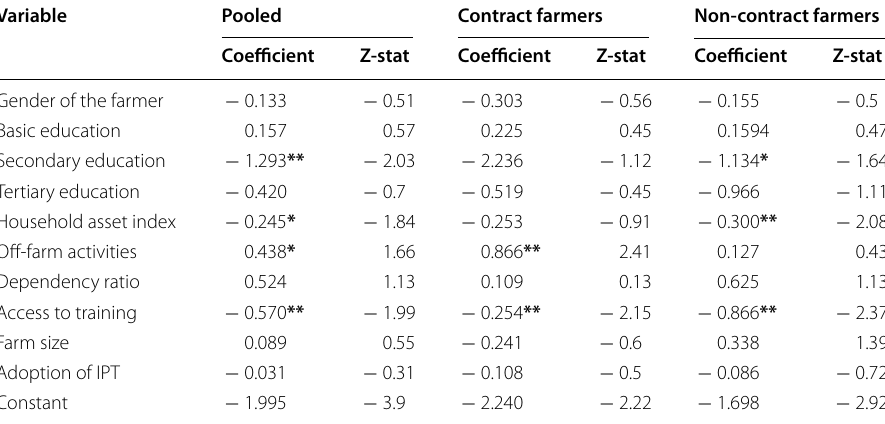
Table 6 Determinants of technical efficiency Variable Pooled Contract farmers Non‑contract farmers Coefficient Z‑stat Gender of the farmer